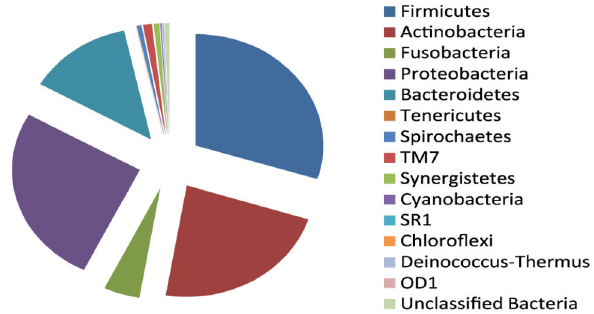
Figure 1. Abundance of the different bacterial phyla detected in clinical samples of root-canal treated